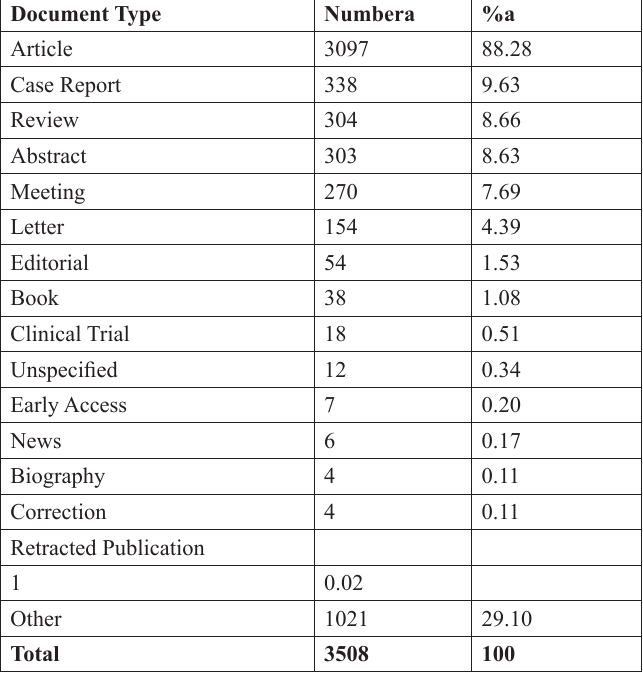
Document types in scientific literature related to mushroom poisoning published between 1975 and